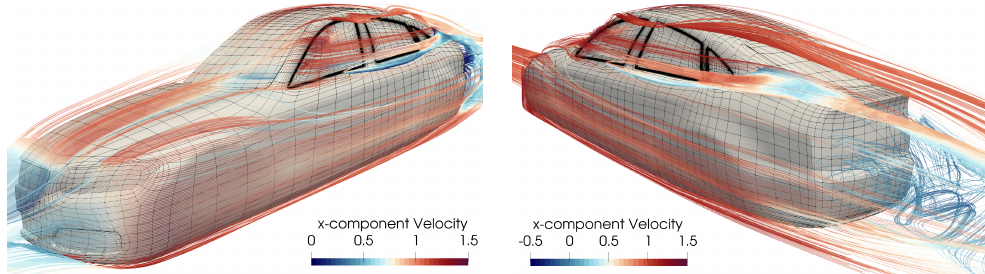
Figure 21. Simplified DrivAer model—Streamlines coloured with the x -component of the velocity for the time-averaged solution from the front ( left ) and the rear ( right ) point of view.